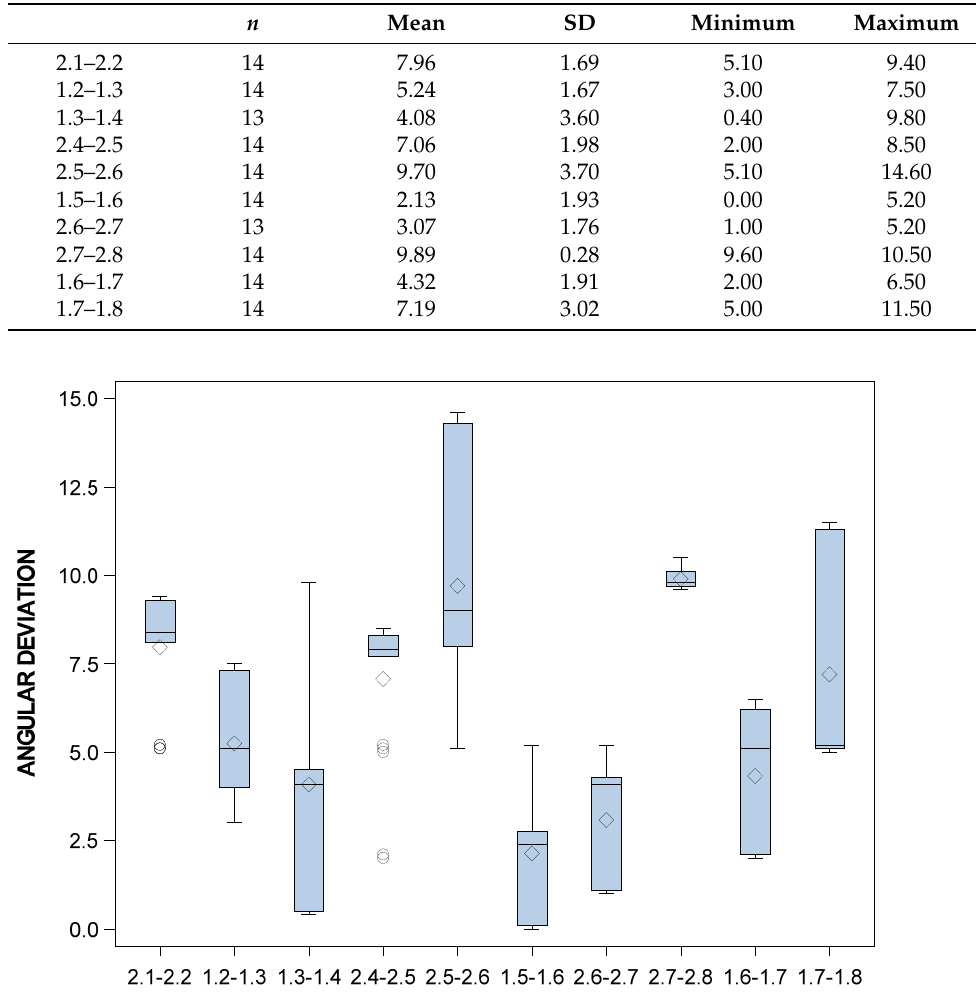
Table 7. Descriptive deviation values at angular level ( ◦ ) of the orthodontic micro-screws placed in the selected tooth positioning.